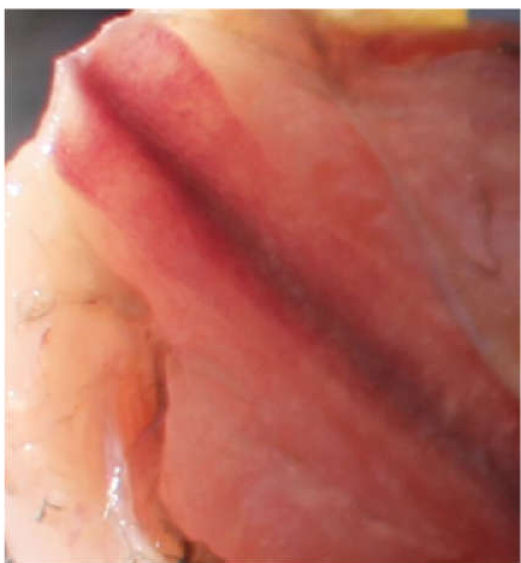
Figure 2. A normal keel bone tip with no fracture lines or